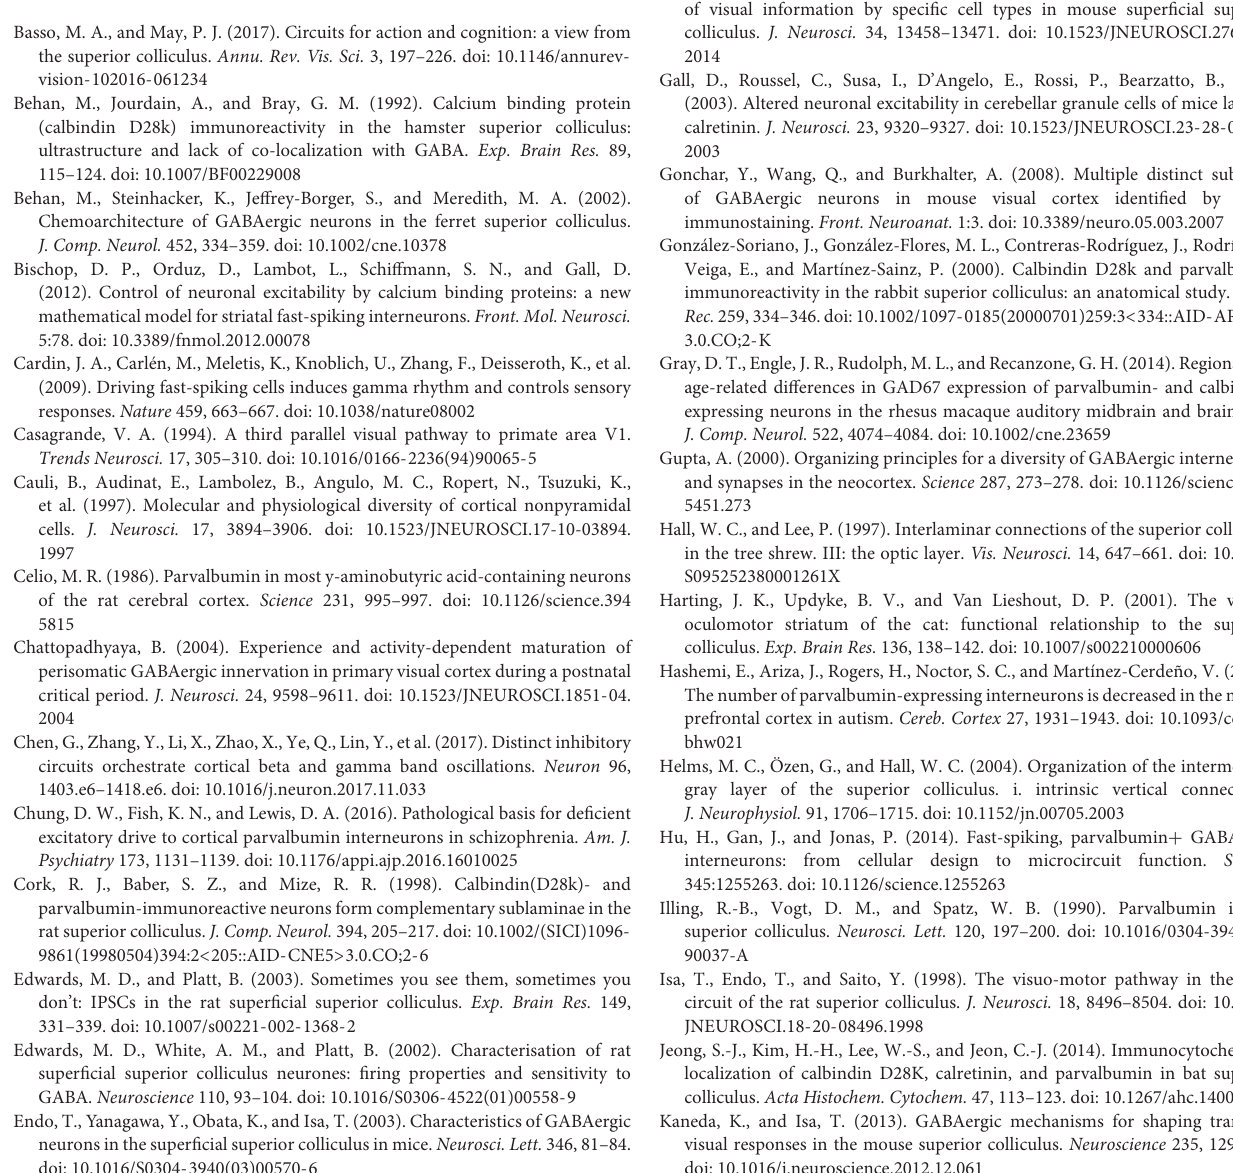
FIGURE S4 | (A) Brief LED blue light pulses (cyan square, 2 ms) effectively evoked action potentials in PV + neurons recorded in slices from Ai32;PV-Cre mice. Representative trace of a PV + neuron (red trace) from sSC recorded in current-clamp configuration without QX-314 in the pipette (dashed lines, 0 mV and − 60 mV). (B) Light-evoked EPSCs recorded at − 80 mV (black trace) were blocked by APV/CNQX (50 µ M/10 µ M) (green trace). After ∼ 15 min washout, the EPSC amplitude was almost completely recovered (red trace). Bicuculline application (10 µ M) did not affect the EPSC amplitude (orange trace). (C) Representative traces showing a PV + driven inhibitory circuits classified as feedforward inhibition. Bath application of APV/CNQX diminished PSCs evoked at − 80 and − 20 mV. After washout, bicuculline selectively inhibited the outward current. Scale: 100 pA/5 ms. FIGURE S5 | Optogenetic stimulation of PV + neurons failed to evoke PSCs in PV − neurons recorded in iSC. (A) Fluorescent image (40 × , GFP) showing a PV +